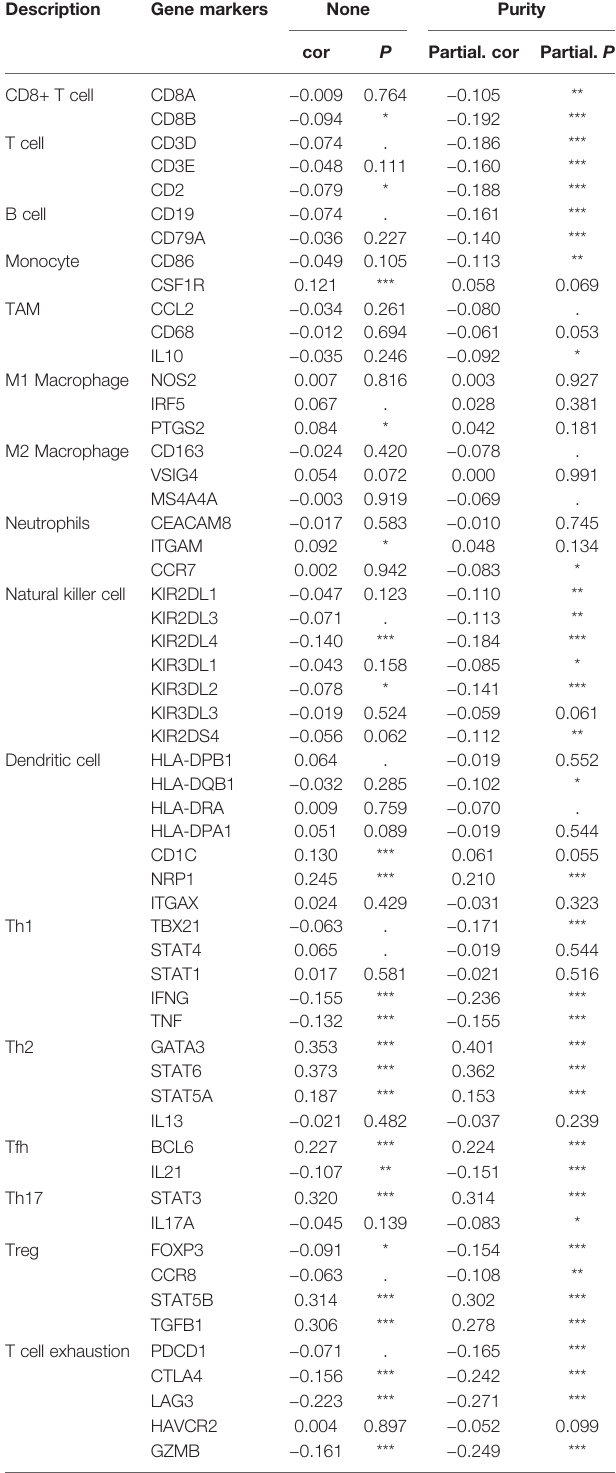
TABLE 2 | Correlation analysis between ITGA3 and gene markers of immune cells in BRCA by TIMER. Description Gene